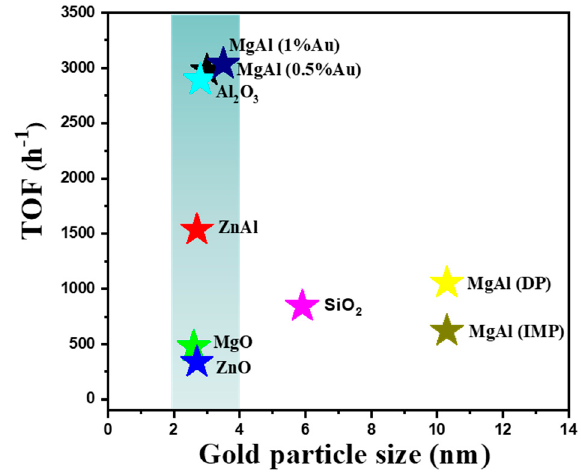
Figure 8. The relationship between turnover frequency values with the particle sizes on different supported gold catalysts with various supports and preparation methods.